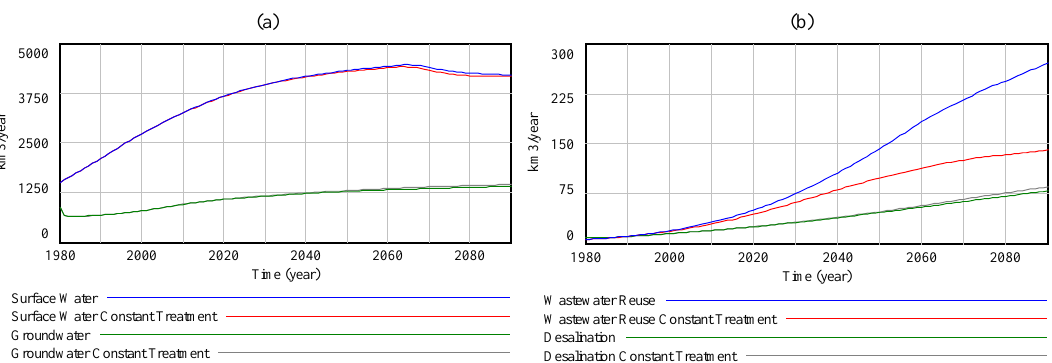
Figure 11. Development of water supplies under the baseline and constant wastewater treatment scenarios for ( a ) conventional water supplies and ( b ) alternative water supplies.